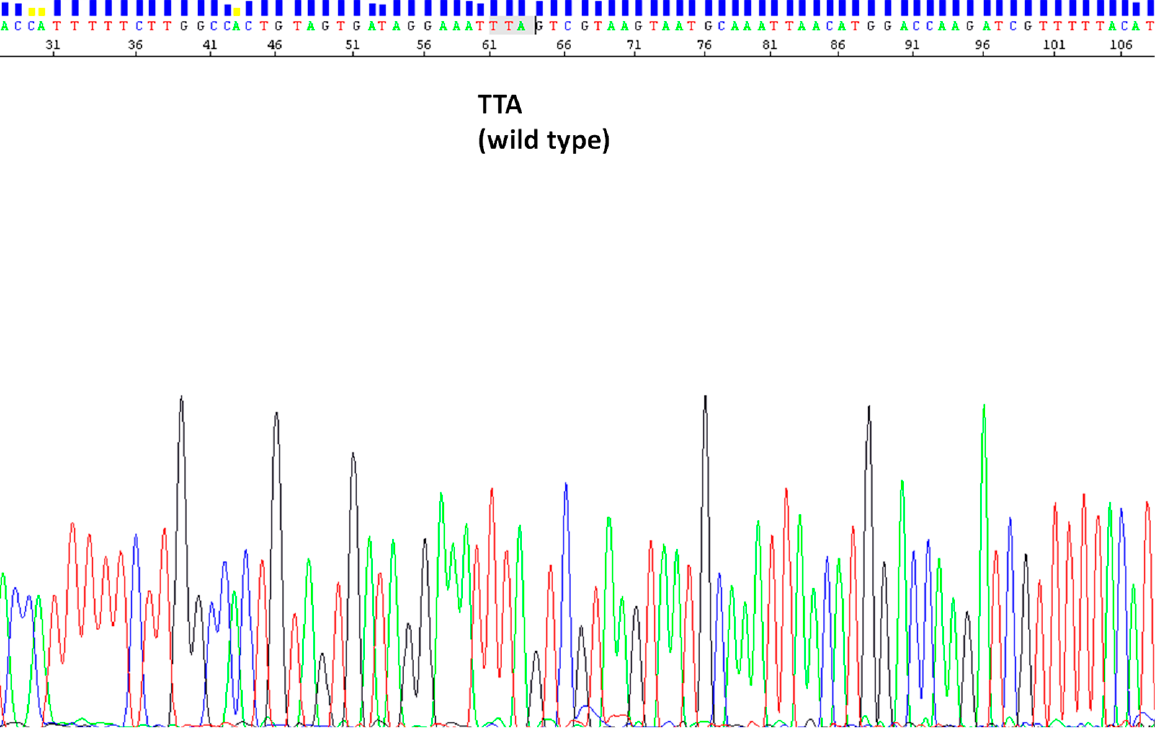
Figure 1. Representative electropherogram of a wild-type (TTA) An. pharoensis sample for the kdr L1014F mutation .